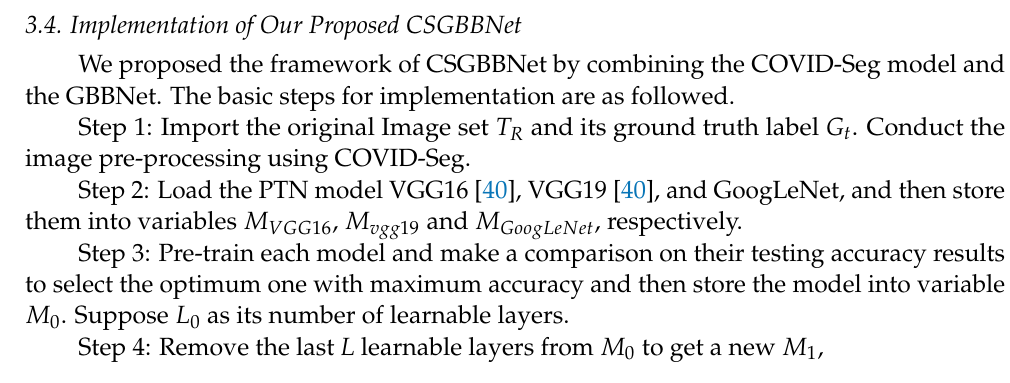
Figure 9. An illustration of fivefold cross-validation.